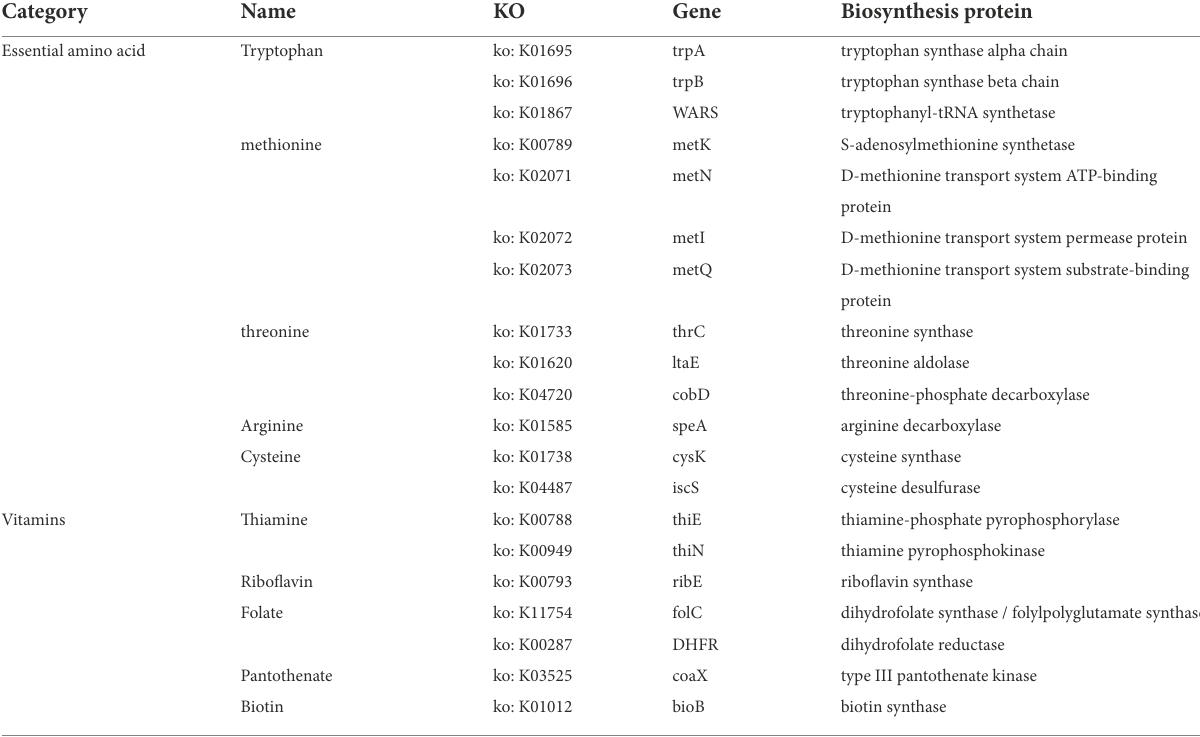
TABLE 1 Associated biosynthetic genes detected in R. intestinalis genome about essential amino acids or vitamins.